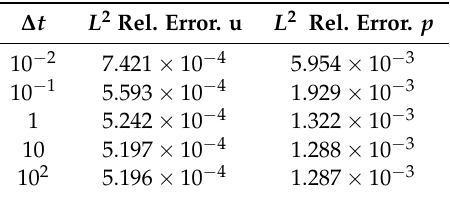
Figure 5. Time evolution of the L 2 -norm of the spatial error for the velocity and the pressure with the Gear 2 scheme for the augmented Lagrangian method with dr = 10 (AL 10) and dr = 100 (AL 100) and for the rotational pressure-correction (RPC). Table 7. L 2 relative errors in space for the non-corrected rotational pressure-correction method for various time steps for the Couette